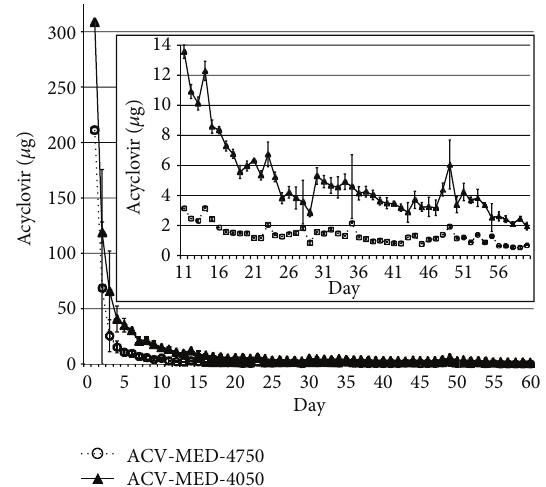
Figure 4: Comparison of in vitro release of acyclovir (ACV) from implants made from MED-4050 and MED-4750 polymers. Silicone rods generated from either MED-4050 or MED-4750 polymers were impregnated with ACV in a 1:1:1 ratio of component A, component B, and ACV, and the release of acyclovir was determined every 24 hours for 60 days. Inset shows a magnified view of days 11 to 60, after initial burst release of ACV. The rate of release of ACV from the implants was determined as described in Section 2. Briefly, implants were suspended in 1mL of phosphate-buffered saline and removed to fresh PBS every 24 hours. Following incubation, each sample was analyzed by HPLC. ACV was quantitated based on comparison with a standard curve. Each point represents the average of five independent samples; error bars denote standard deviation of the